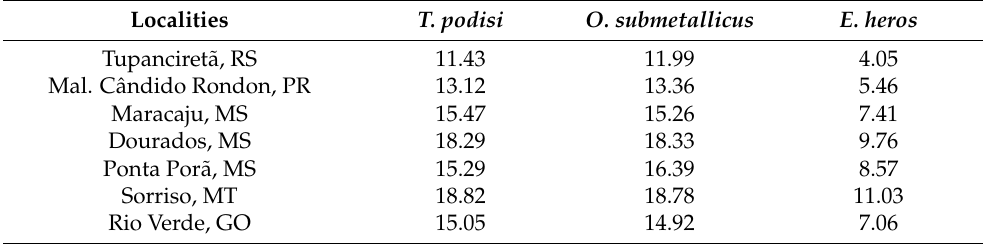
Table 2. Estimated number of generations per year of Telenomus podisi, Ooencyrtus submetallicus, and Euschistus hero , considering climatic data for seven soybean-producing areas of Brazil.